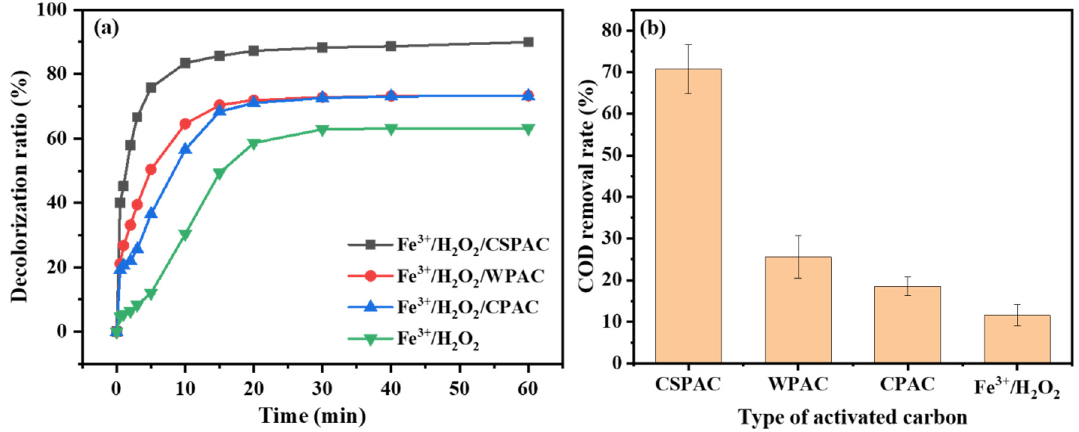
Figure 1. ( a ) Decolorization rate and ( b ) COD removal rate of ARG degradation in Fe 3+ /H 2 O 2 /CSPAC, Fe 3+ /H 2 O 2 /WPAC, Fe 3+ /H 2 O 2 /CPAC, and Fe 3+ /H 2 O 2 systems (conditions: 0.1 mmol/L FeCl 3 , 0.2 mmol/L H 2 O 2 , 100 mg/L ARG, 0.4 g/L PAC (75 μ m particle size), pH = 3).